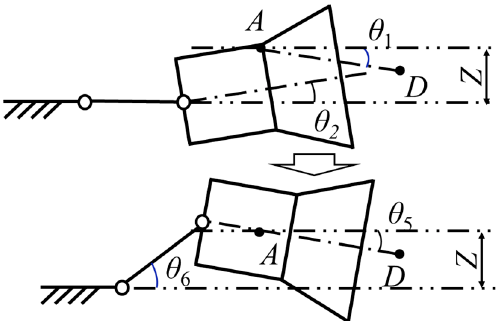
Figure 20. The schematic diagram of connecting the universal wrench with the bolt. ( a ) No eccen- tricity. ( b ) Eccentricity.